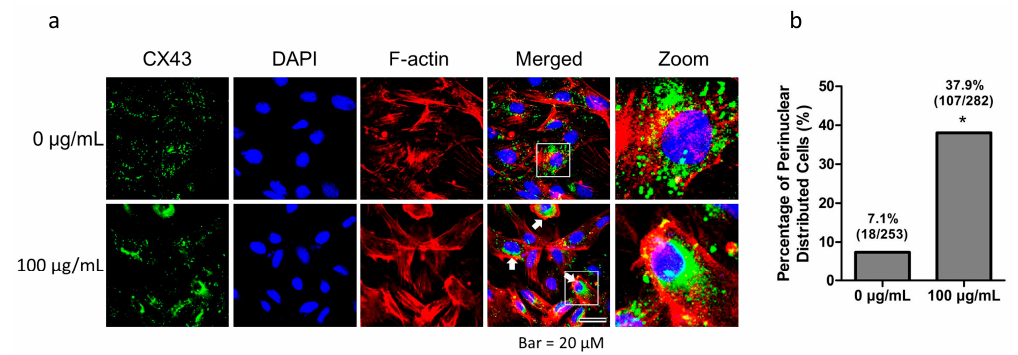
Figure 3. Fullerenol induces connexin 43 (CX43) perinuclear distribution. Freshly isolated granulosa cells were routinely cultured for 4 days for attachment and were then treated with 100 μ g/mL fullerenol for 2 h. Cellular distribution of CX43 was evaluated. ( a ) Immunofluorescent analysis of CX43 (green, scale bar: 20 μ m). Fullerenol treatment caused CX43 perinuclear distribution compared with the control group (indicated by white arrow). The white squares indicate the distinctive cells and are zoomed. Blue and red color indicate nuclear staining and F-actin skeleton, respectively; ( b ) Percentage of granulosa cells with CX43 perinuclear distribution; * indicates the test statistic was greater than the critical value when the two percentages were compared.